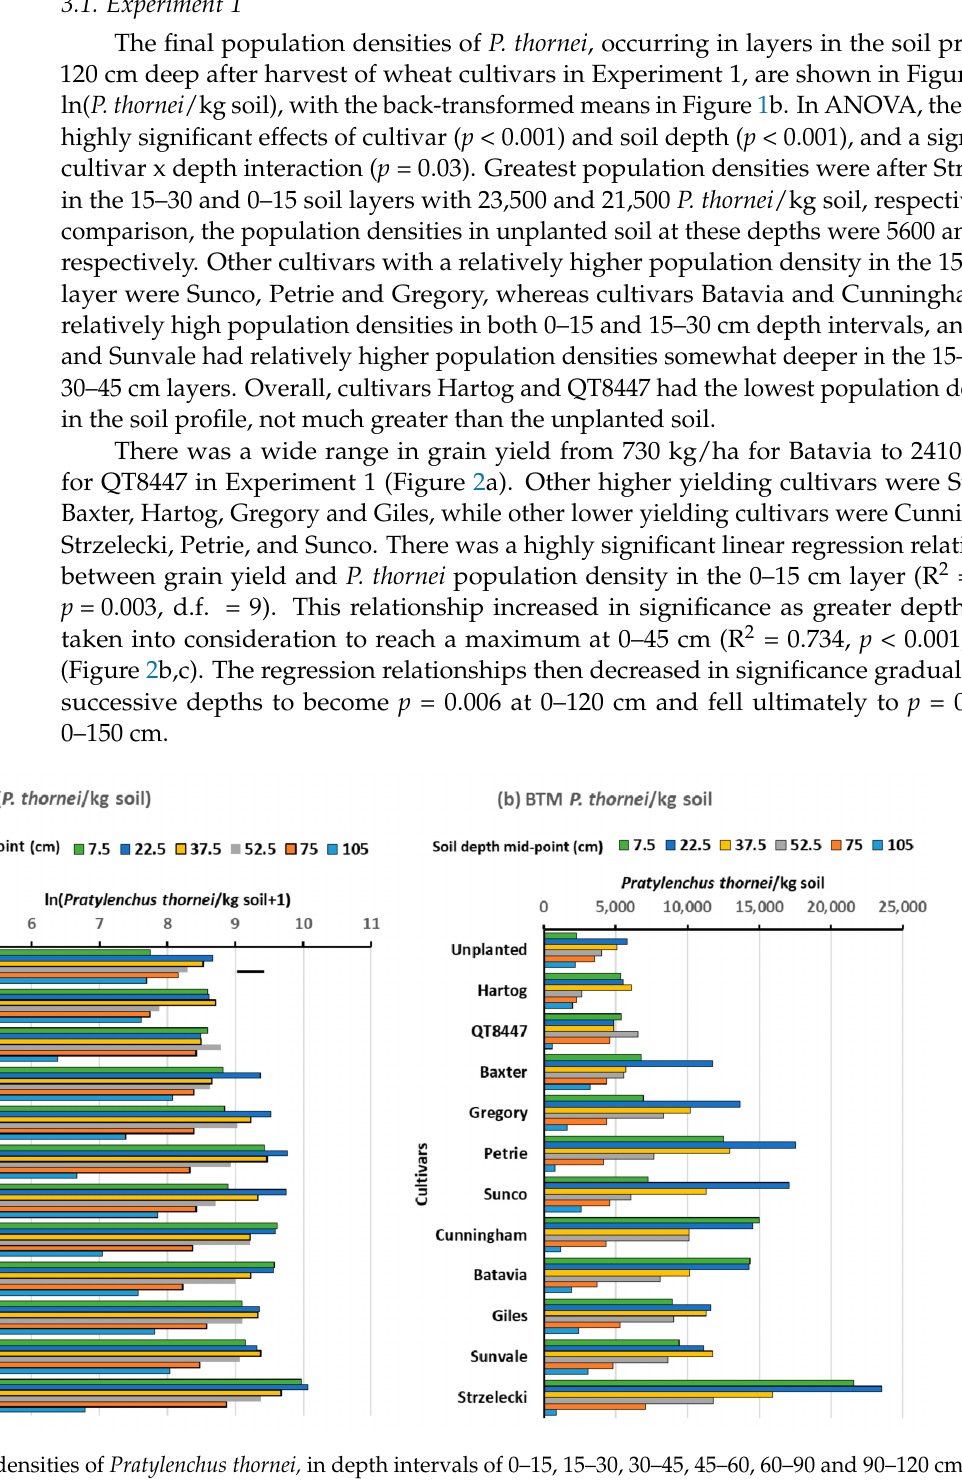
Figure 1. Population densities of Pratylenchus thornei, in depth intervals of 0–15, 15–30, 30–45, 45–60, 60–90 and 90–120 cm in the soil profile, after harvest of 11 wheat cultivars in Experiment 1, ( a ) mean values for ln( P. thornei /kg soil+1) from ANOVA with bar marker representing l.s.d. ( p = 0.05) for cultivar x depth interaction, ( b ) back-transformed values of number of P. thornei /kg soil. Cultivars are arranged in ascending order of mean P. thornei population